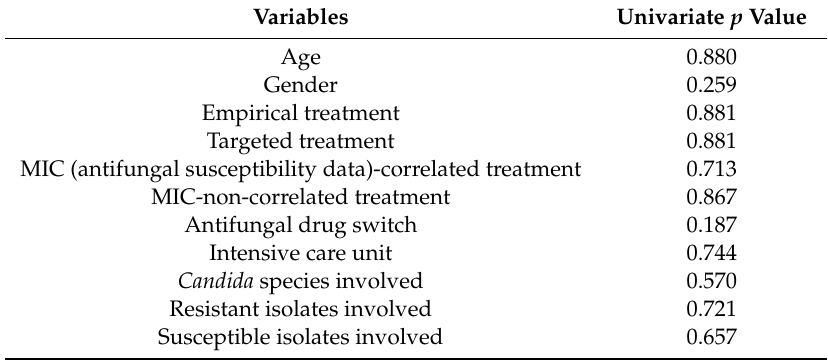
Table 4. Univariate analyses of 14-day fungal free blood cultures elated to the various treatment